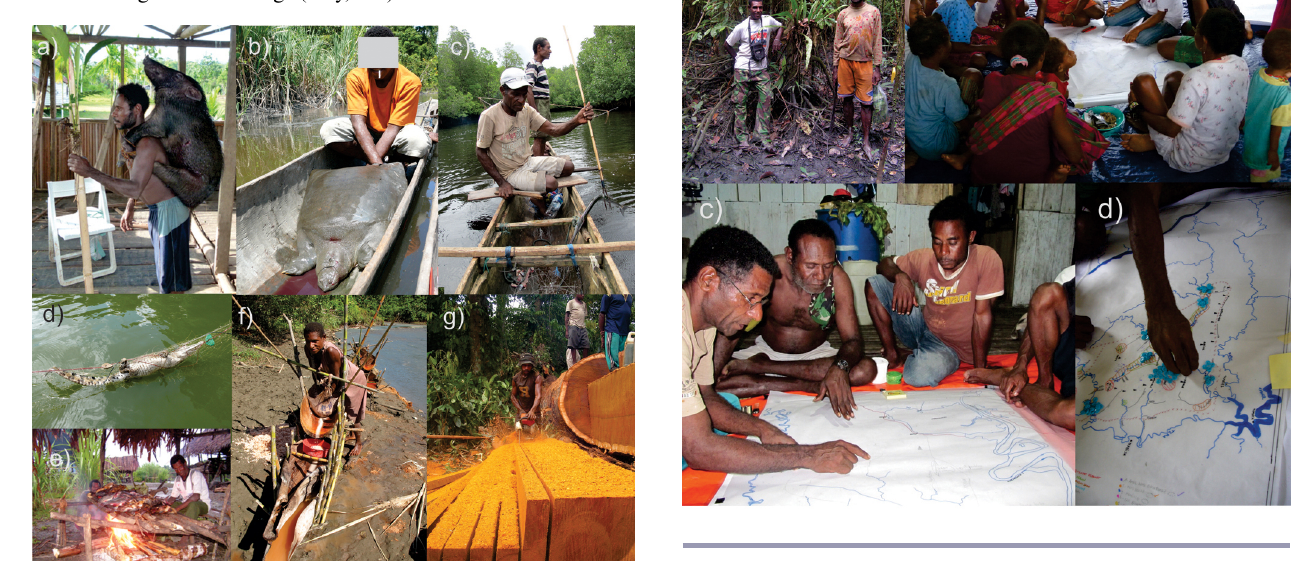
Fig. 3 . Selected livelihood activities based on natural resources. (a) Hunter carries a pig back to the village (Metaweja, GB); (b) harpoons (Yoke, MB); (d) young crocodile, Crocodylus